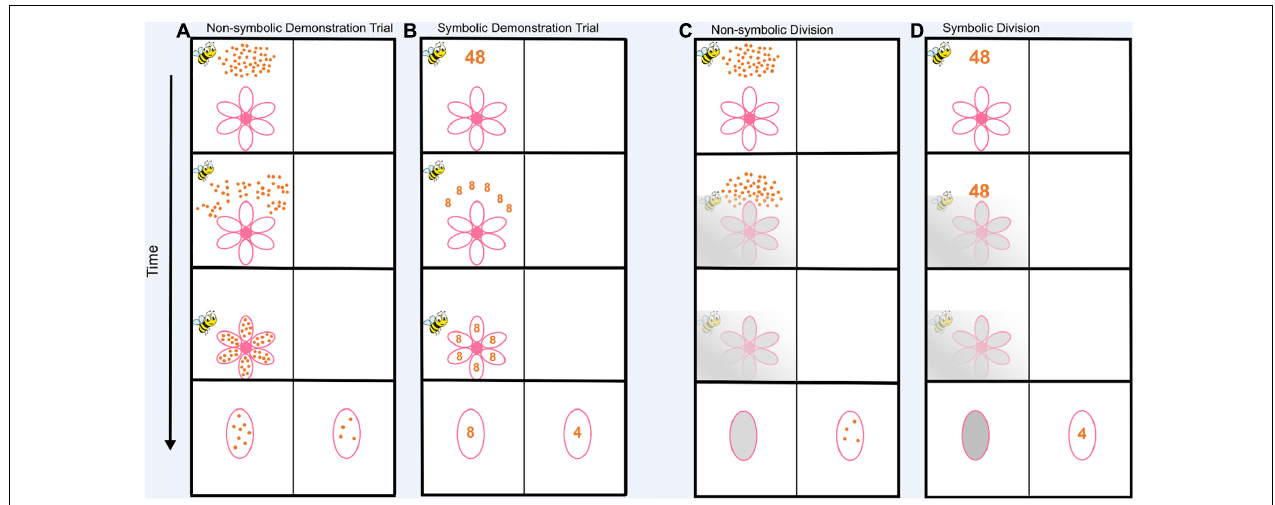
FIGURE 1 | Schematic of the non-symbolic and symbolic division tasks. (A) Demonstration trials for the non-symbolic task. Children and adults watched as the dots on the top of the screen fell onto the petals below. Then, one of the flower petals moved toward the center of the left side of the screen and the target petal appeared with a new quantity of dots to compare on the right side of the screen. Participants responded by touching the petal with the greater quantity of dots. Participants completed 8 demonstration trials. The demonstration trials are not included in any analysis. (B) The demonstration trials for the symbolic version of the task. Participants watched the numeral at the top of the screen split apart and change into the numerals that landed on the flower at the bottom of the screen. (C) Experimental trials for the non-symbolic division task. The task was identical to the demo trials, except that as the dots fell to the bottom of the screen a cloud appeared that obscured how many dots fell onto each petal. Then the obscured petal moved to the middle of the left side of the screen and subjects had to imagine how many dots were on this petal and compare it to the visible target quantity. (D) The experimental trials for the symbolic version of the task. Participants watched the dividend numeral move and disappear into the fog without viewing the quotient. Then participants compared their imagined quotient to the new target number on the right side of the screen. For a video of the division tasks please see